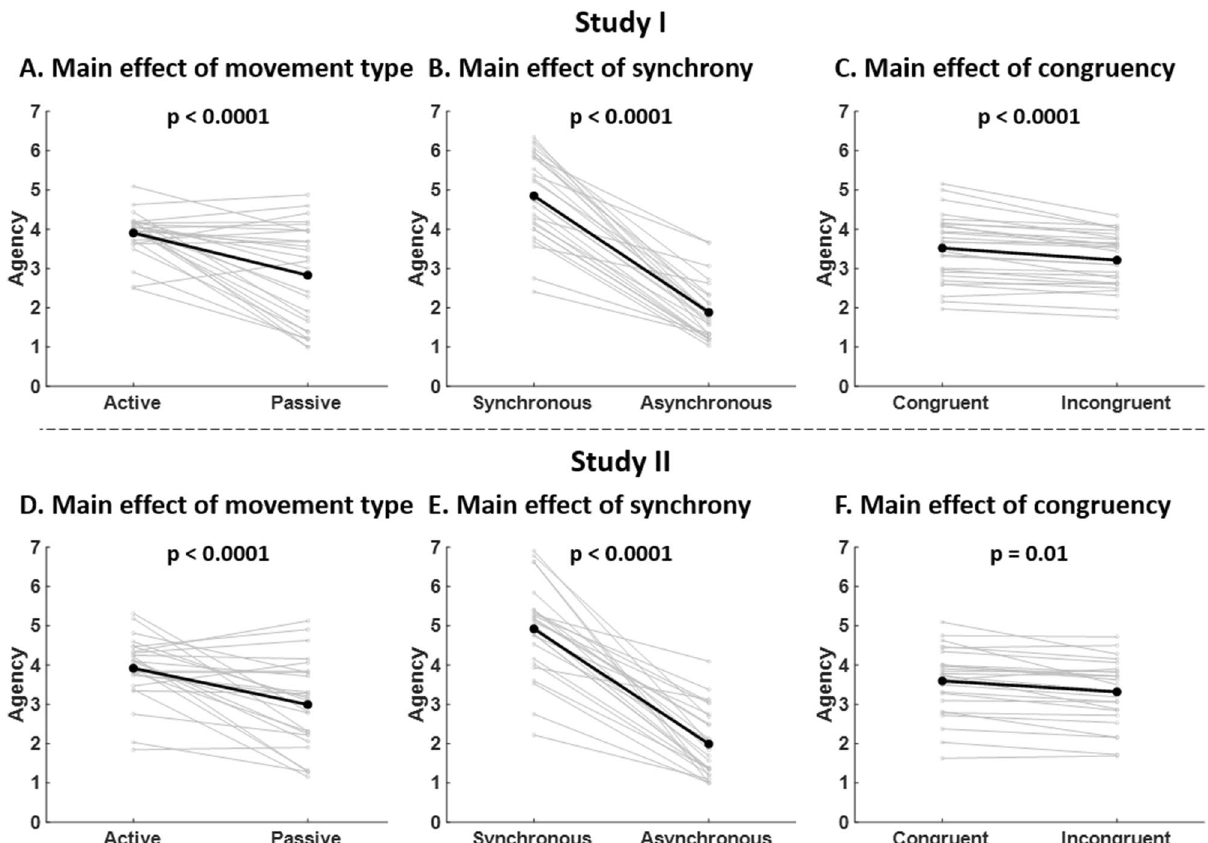
Figure 4. SA ratings (Studies I and II). ( A – D ) SA ratings for active and passive conditions are shown for Studies I and II. ( B – E ) SA ratings for synchronous and asynchronous conditions are shown for Studies I and II. ( C – F ) SA ratings for congruent and incongruent conditions are shown for Studies I and II. For each panel, data plotted in grey represent the mean rating for individual subjects and data plotted in black represents the mean rating across subjects. The p-values correspond to the main effects reported in Table